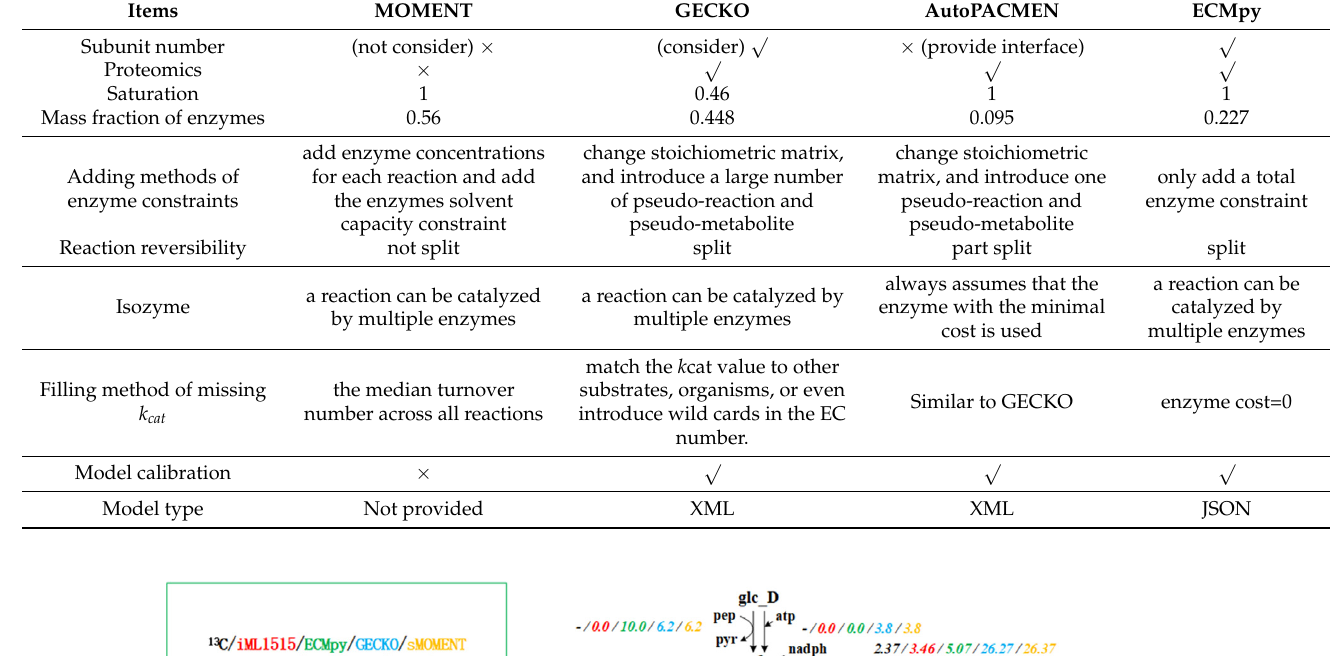
Table 1. Comparison of the Construction Methods of Enzyme-constrained Model.